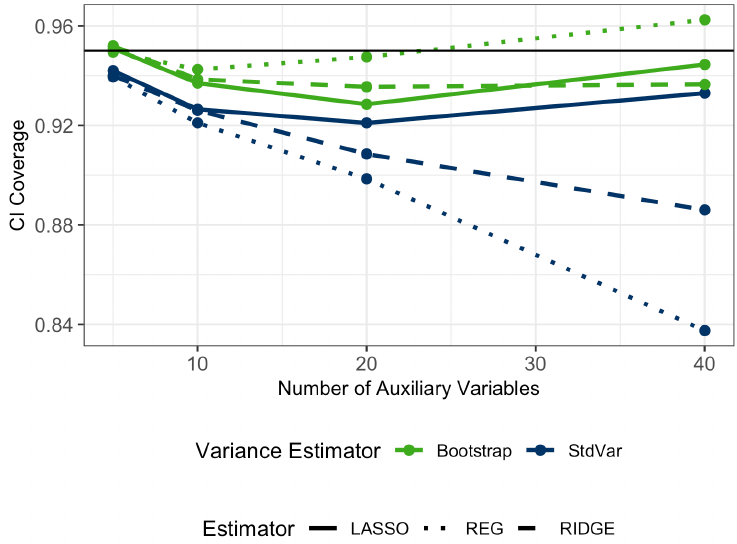
Figure 8. Confidence interval coverage for REG, LASSO, and RIDGE as the number of predictors